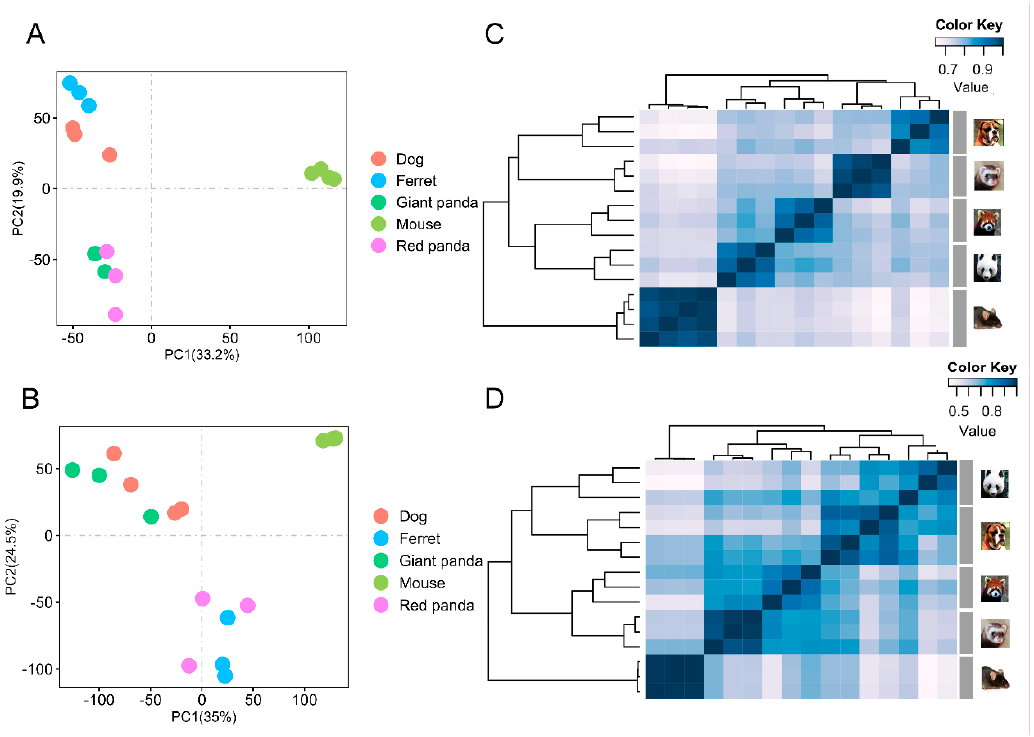
Figure 1. PCA and clustering analyses of the mRNA expressions for all samples. The expression levels of all orthologous genes were normalized and log-transformed to perform PCA in stomach samples of all species. Different species are represented by circles of different colors ( A ). The expression levels of all orthologous genes were normalized and log-transformed to perform PCA in small intestine samples of all species. Different species are represented by circles of different colors ( B ). The expression levels of all orthologous genes were normalized and log-transformed to perform cluster analysis in stomach samples of all species. Distance between samples was measured using Spearman’s rank correlation coefficient ( C ). The expression levels of all orthologous genes were normalized and log-transformed to perform cluster analysis in small intestine samples of all species.